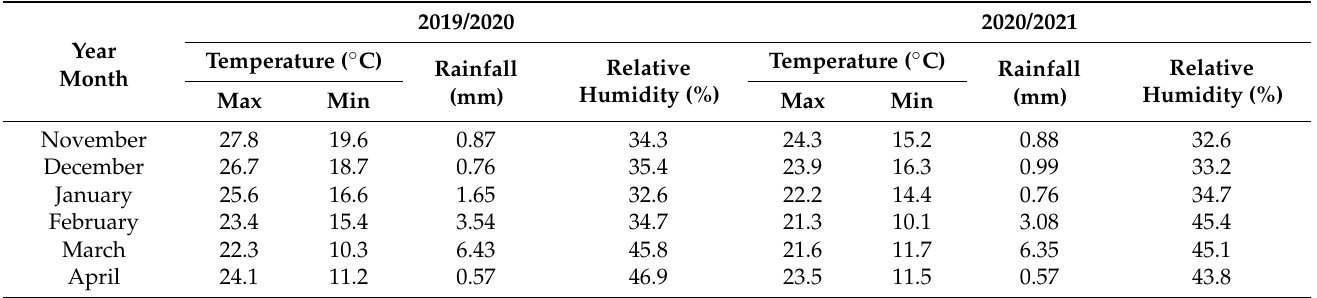
Table 5. Meteorological data of the experimental sites during the 2019/2020 and 2020/2021 growing seasons.